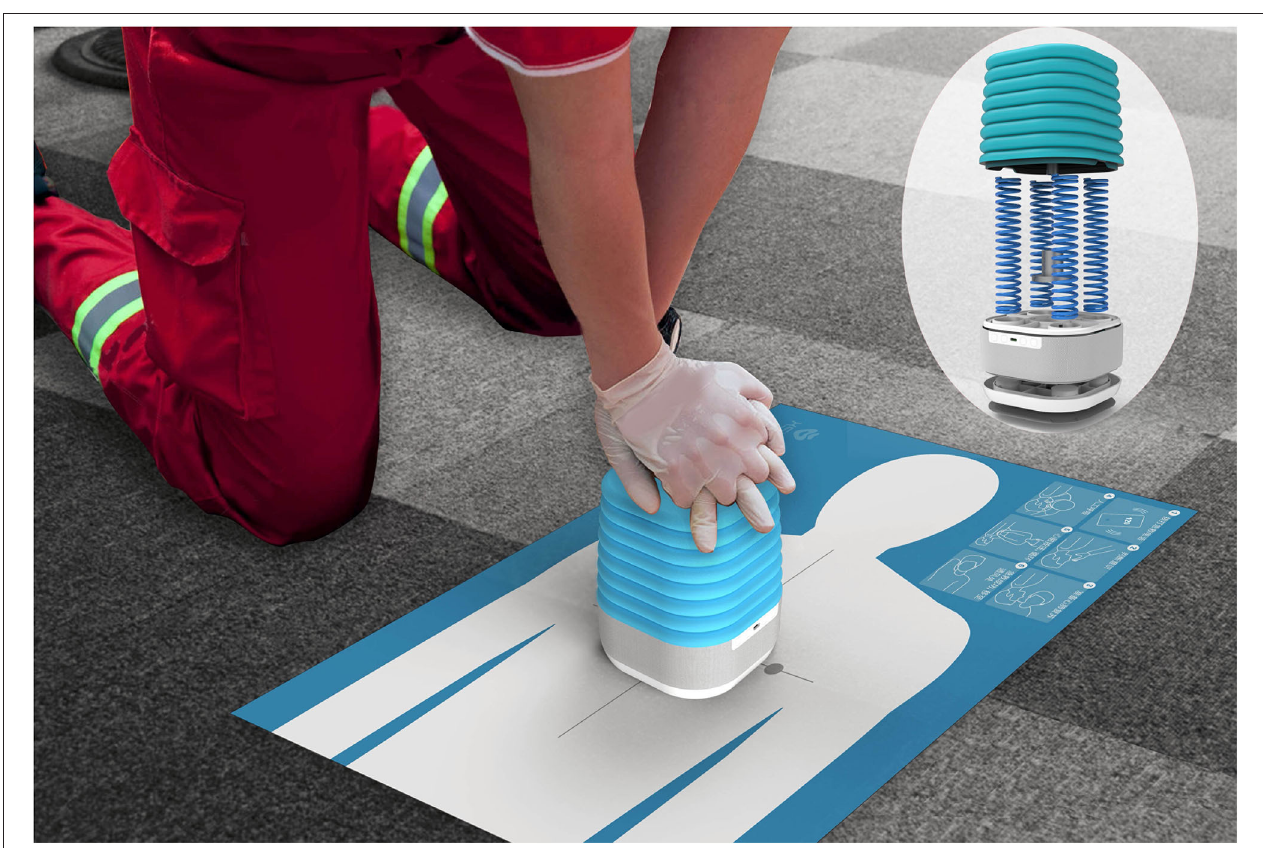
FIGURE 1 | The schematic diagram for the Soul Sheath TM training device. The device is composed of a cover made of silica gel, four springs and a base with a Bluetooth connector, and a sensor monitoring the distance of movement induced by the compression and the rate of compression. The speaker and the indicator light are also integrated into the base. There is also a sheet with a brief instruction of the cardiopulmonary resuscitation process and an upper half of a human shape to mark the position of chest